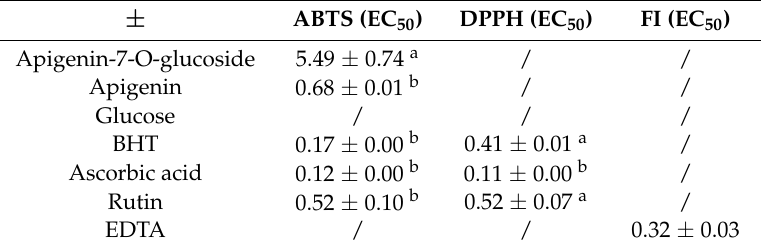
Table 2. Antioxidant activities of apigenin-7-O-glucoside, apigenin, and glucose ± ABTS (EC 50 ) DPPH (EC 50 ) FI (EC 50 )